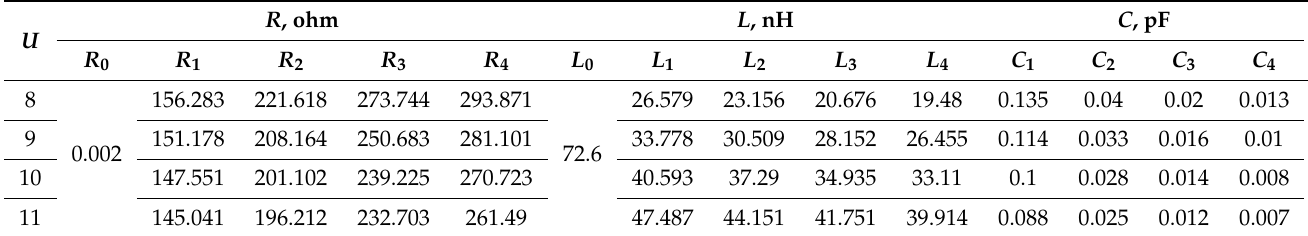
Table 1. Equivalent circuit components for U = 8, 9, 10, and 11.